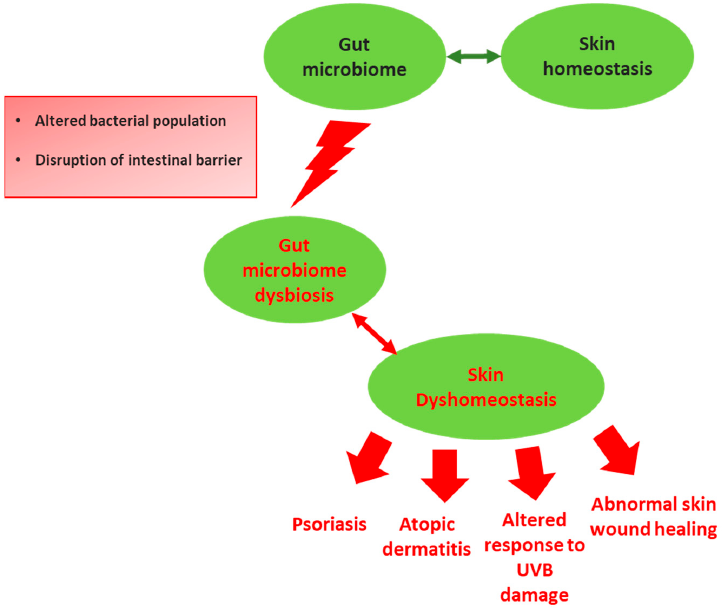
Figure 1. Schematic illustration of the correlation between gut microbiome (GM) and skin homeostasis. GM is the major regulator of the gut–skin axis: in fact, perturbations of GM homeostasis (dysbiosis) provoke also an altered skin environment. This condition increases the predisposition for the host to develop skin diseases and/or altered responses to skin damages.